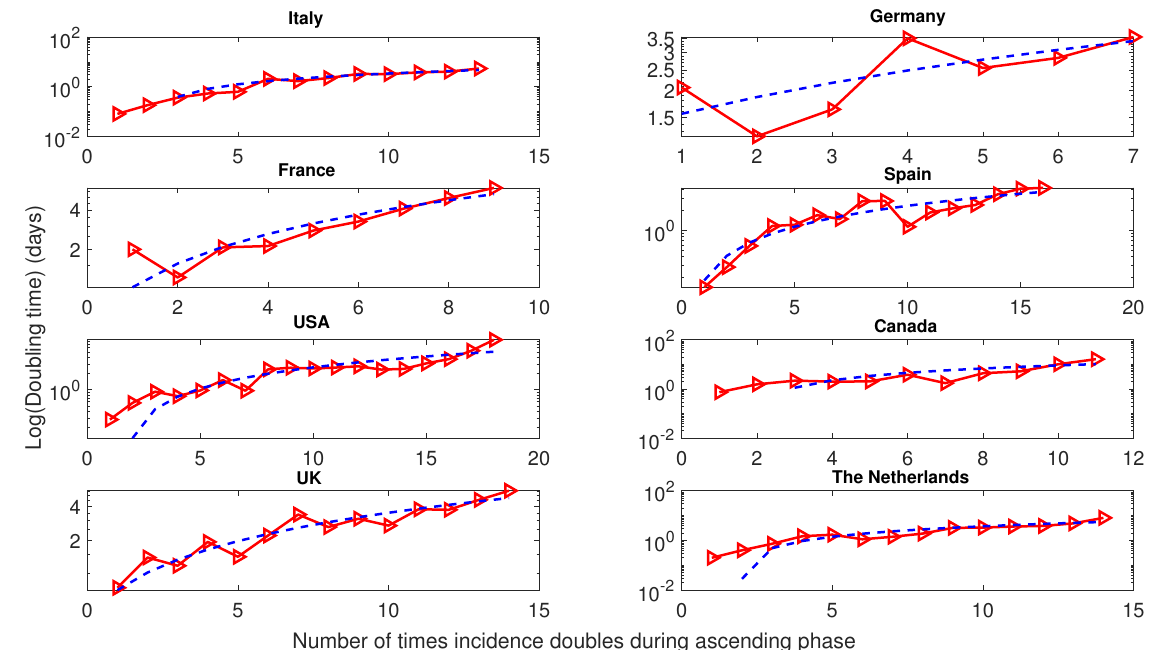
Figure 5. The evolution of the doubling times during the early phase of the COVID-19 epidemics in various hotspot countries. The blue dashed line corresponds to the fit of Generalized-Growth model that characterizes the evolution of the doubling times obtained from the data (red